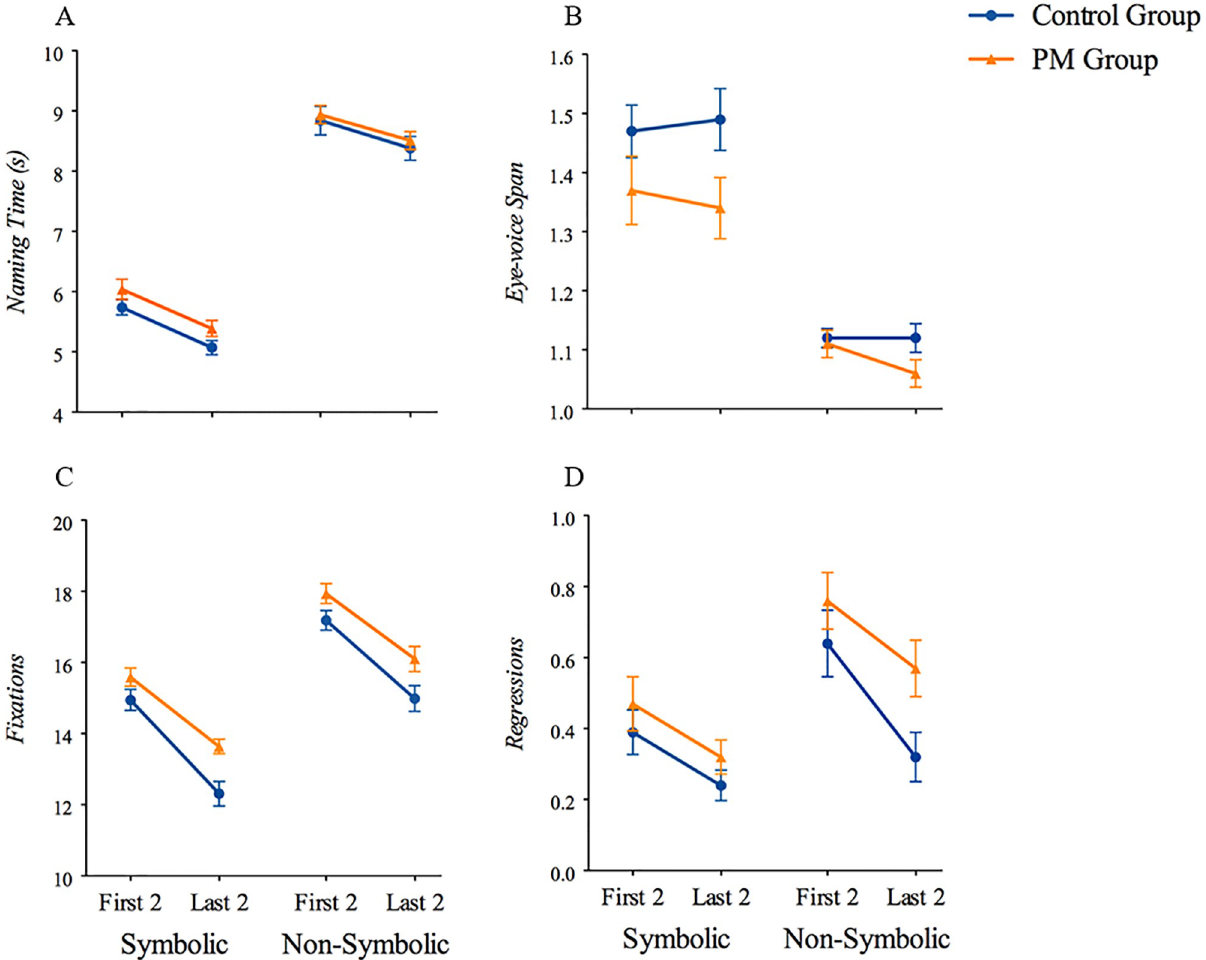
Fig 1. Group differences in RAN naming and gaze between PM and control groups, presented for the first 2 vs. last 2 rows of the RAN arrays. (A) Naming time, (B) Eye-voice span, (the PM group exhibited shorter EVS during the last two rows of the symbolic conditions; p < .05), (C) Overall number of fixations, (PM group made more fixations during the last two rows; both symbolic p < .01 and non-symbolic conditions p < .05), and (D) Regressive fixations, (PM group made more regressive fixations during the last 2 rows of the non-symbolic condition, p < .05).